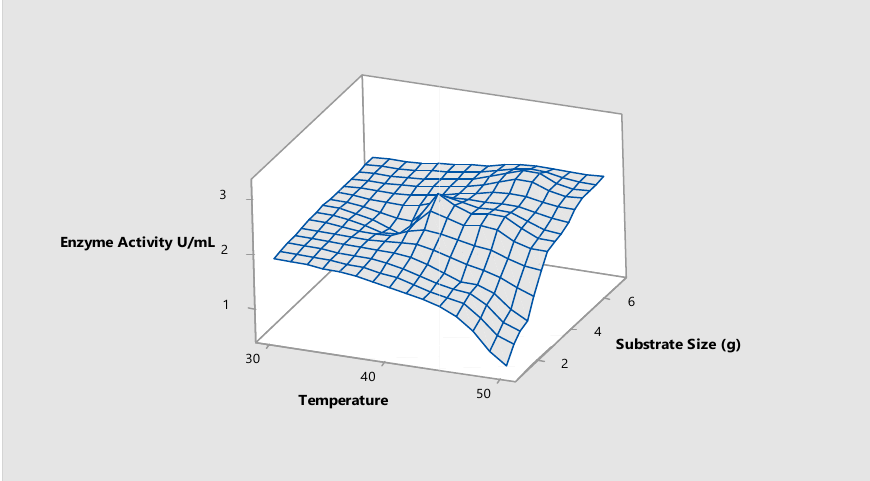
Figure 4. Surface plot of Enzyme Activity (U/mL) vs. Substrate Size and Temperature.